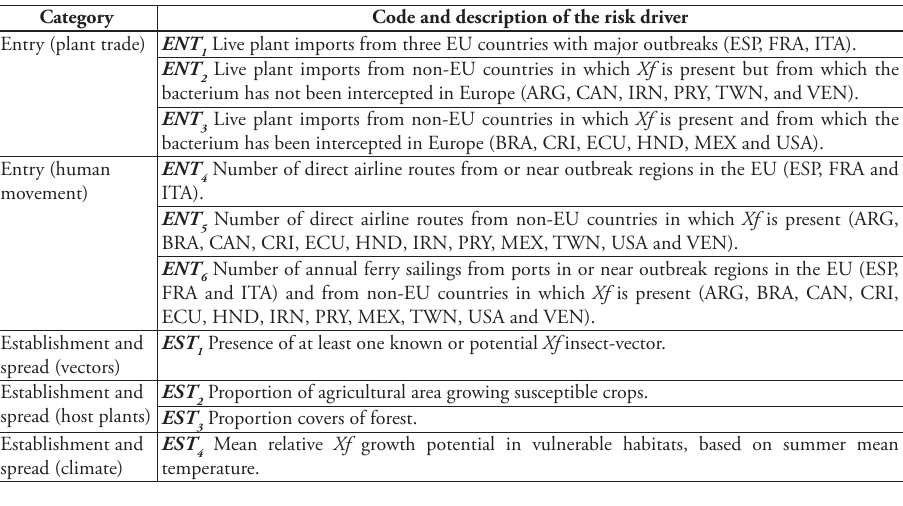
terial 2: Table S1). Xf is known to infect over 563 cultivated and ornamental herba- ceous, shrubby and woody species present in cultivated fields, gardens, parks, woods